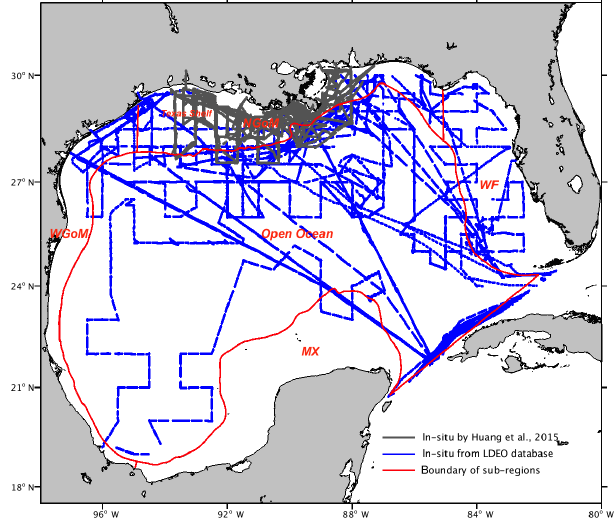
Figure 5. Locations of in situ measurements from the LDEO database (blue) and Huang et al. (2015, grey) in the period of 2005–